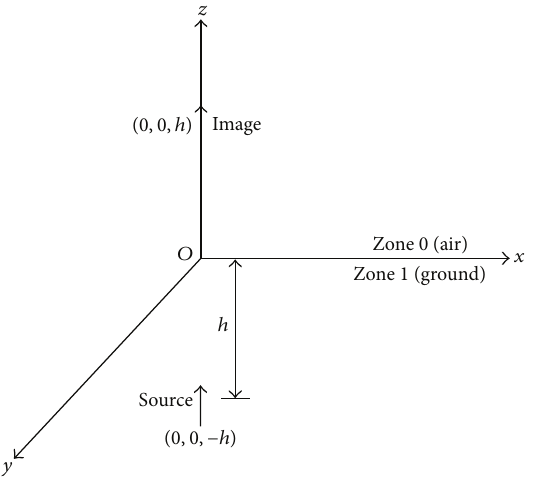
Figure 1: Schematic of the vertical